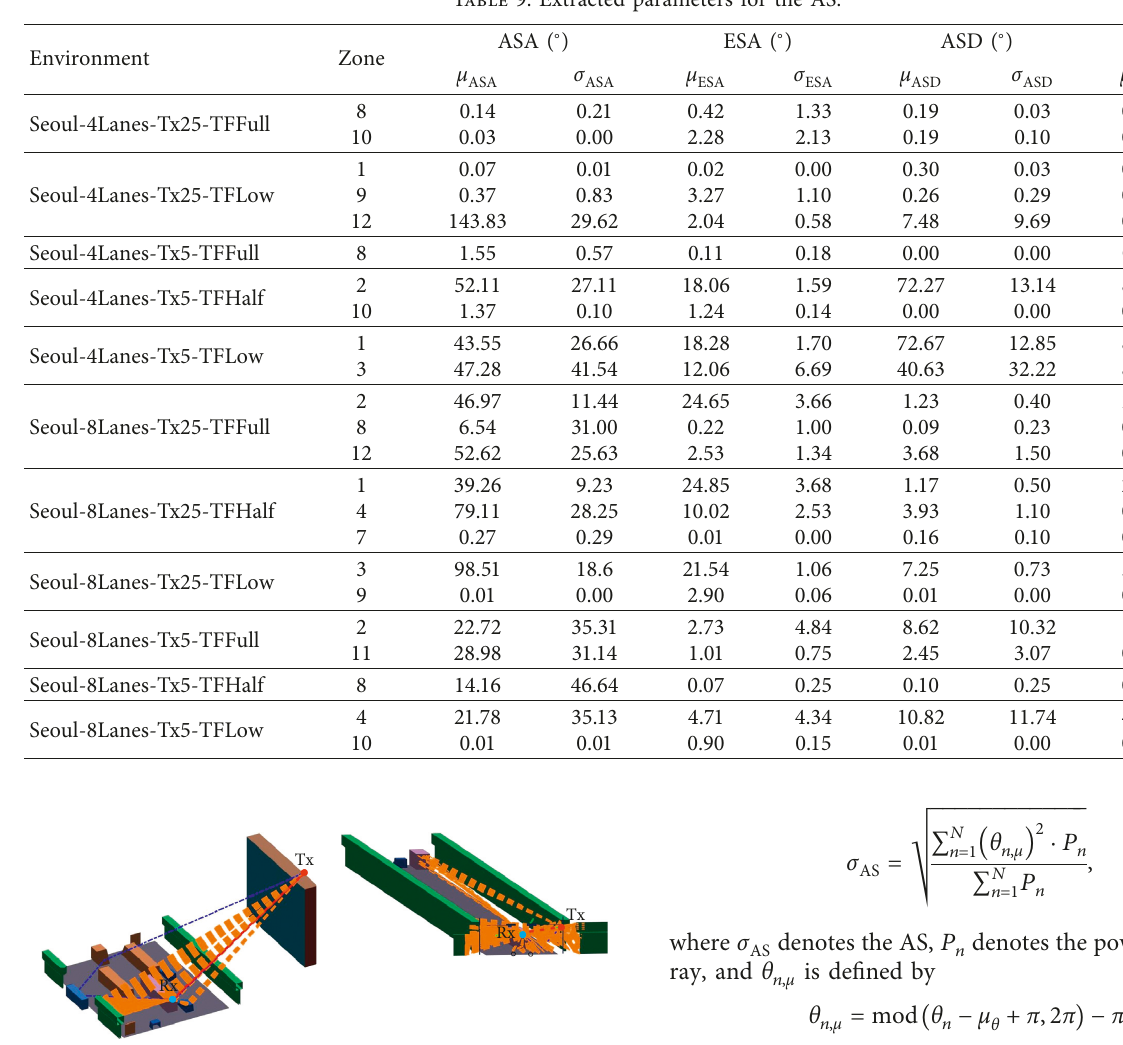
Table 9: Extracted parameters for the AS.